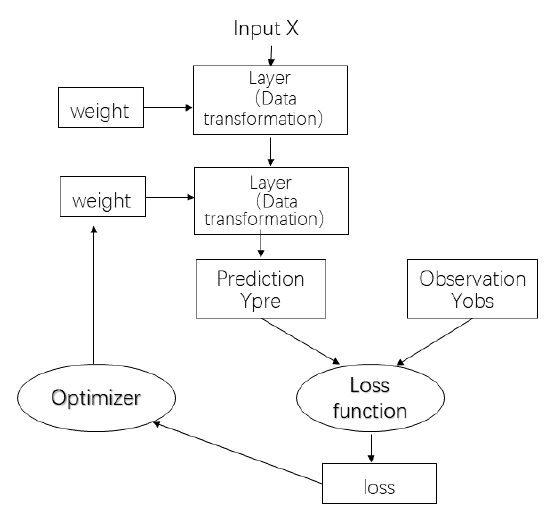
Figure 2 . Relationship among network, layer, loss function, and optimizer. Figure 2. Relationship among network, layer, loss function, and